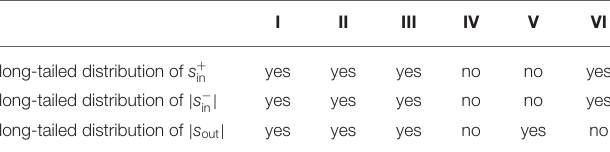
TABLE 1 | A summary of the features of the average synaptic weights distributions of networks I–VI. I II III IV